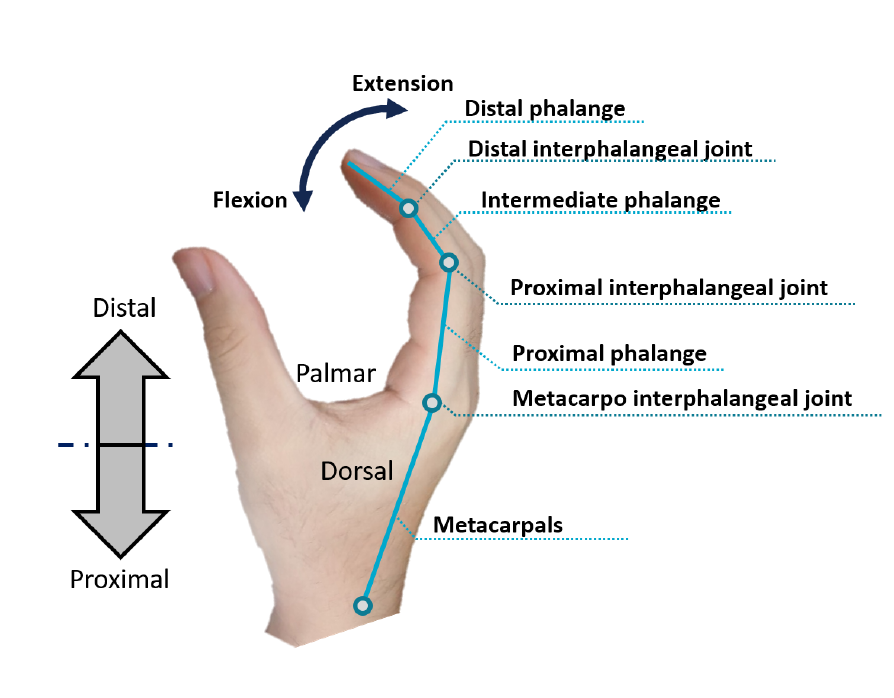
Figure A1. Brief explanation of how the parts of the hand are